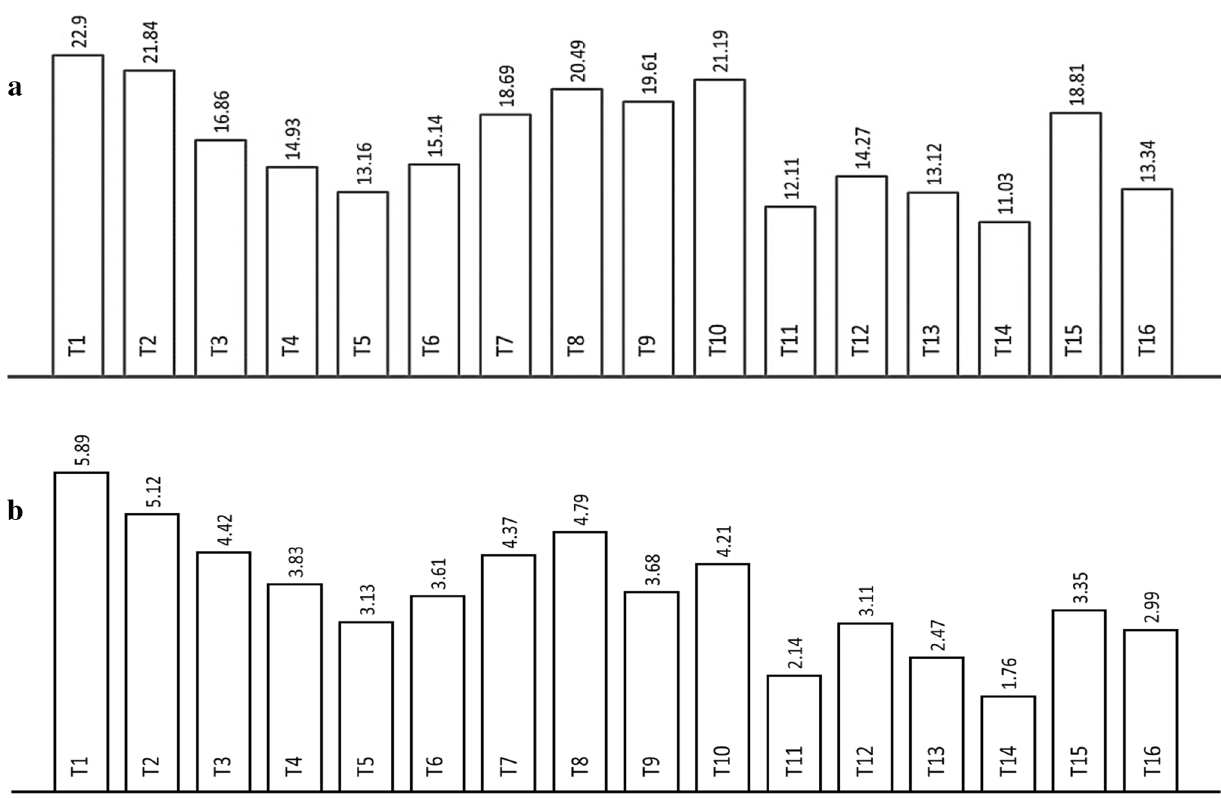
Fig. 2 IFTs of the sixteenth tests; a [C 8 Py][Cl] with the presence of KCl, K 2 SO 4 , MgSO 4 and NaCl at different concentration levels, and b [C 18 Py][Cl] with the presence of KCl, K 2 SO 4 , MgSO 4 and NaCl at different concentration